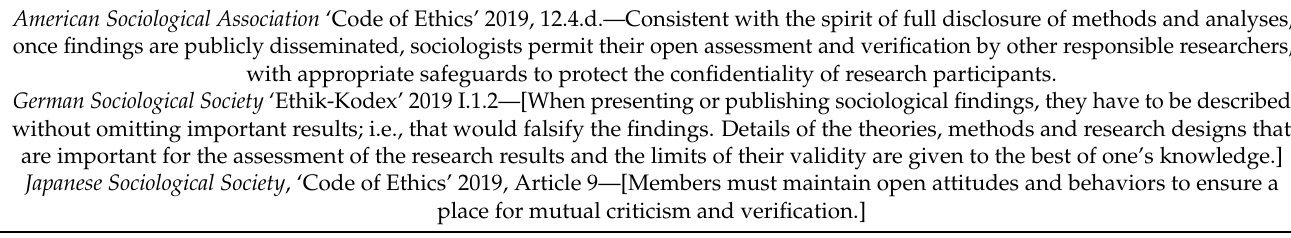
Table 1. Transparency in sociological association ethics